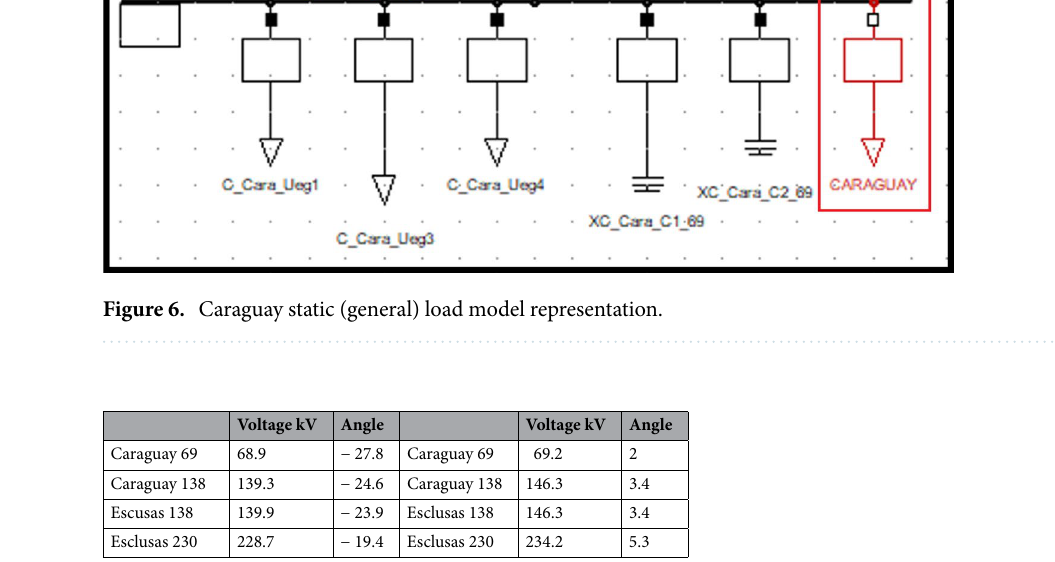
Table 6. Magnitude and angle variation before (left) and after (right) entering Caraguay static load model.